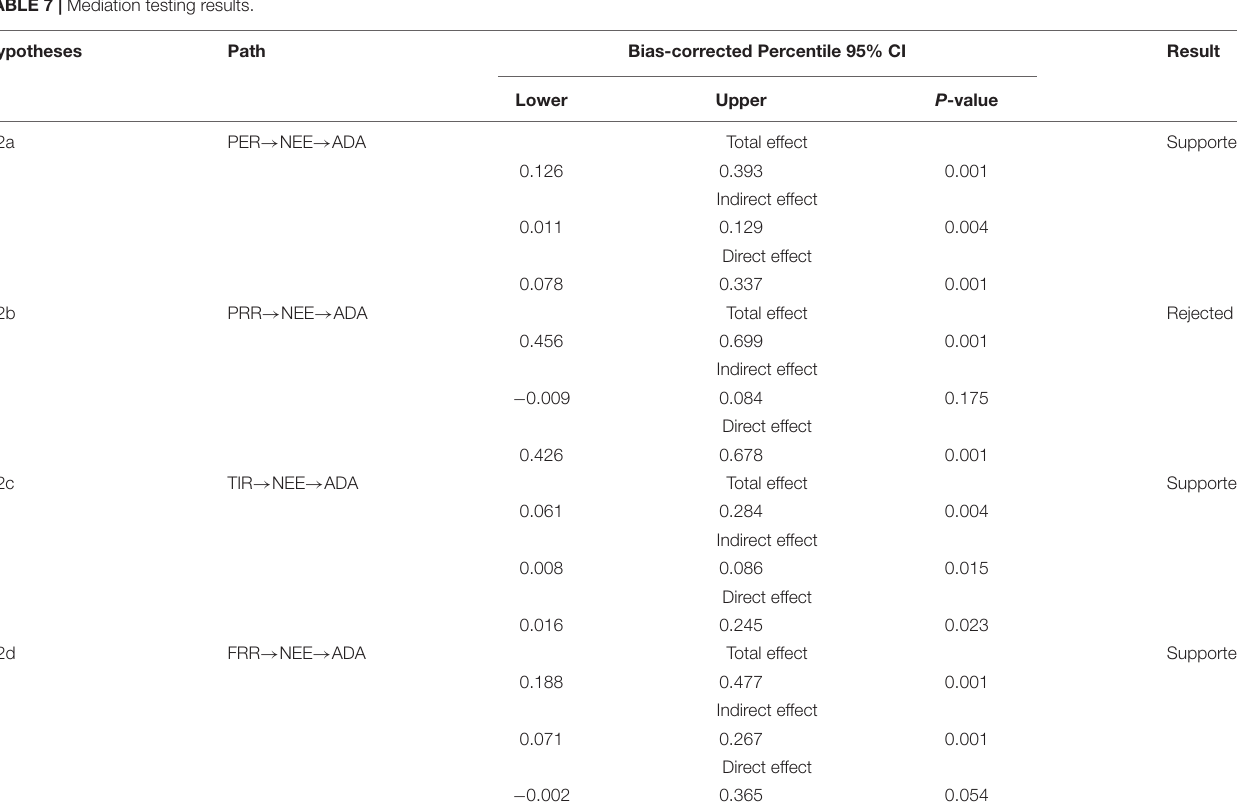
TABLE 7 | Mediation testing